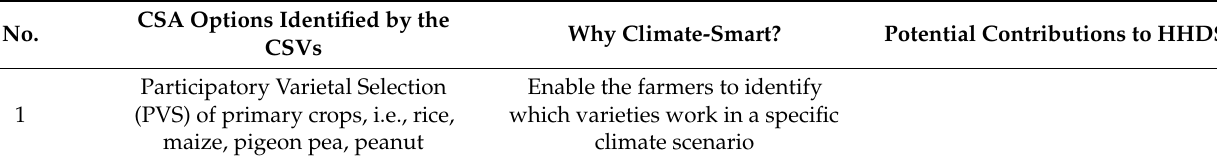
Table 5. Contributions of climate-smart agriculture options to diet